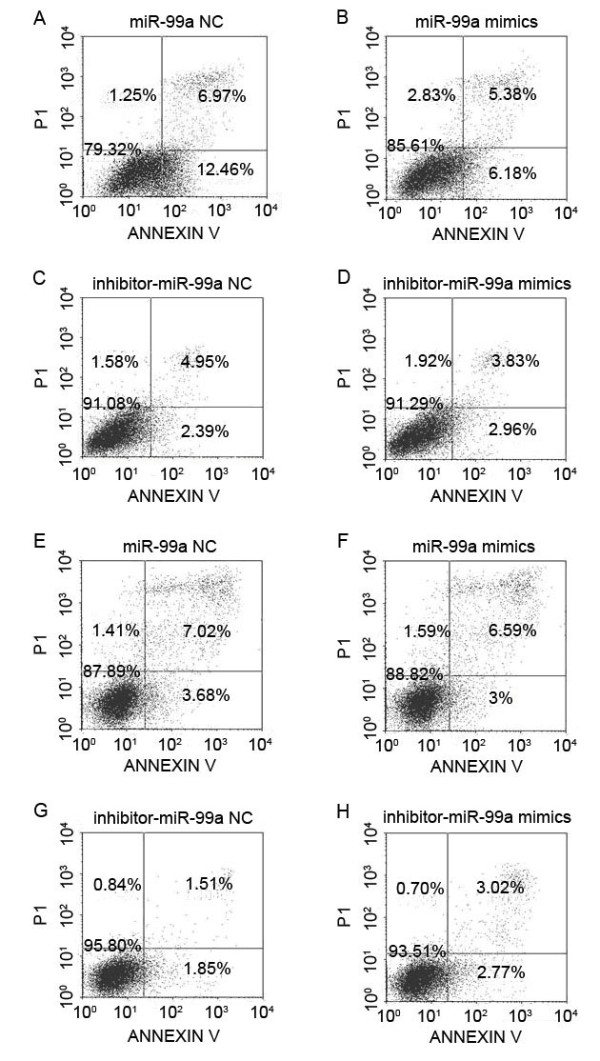
MiR-99a inhibits the apoptosise of HL60 and K562 cells. Apoptosis assessment by Annexin V/propidium iodide staining shows the apoptotic rates of K562 and HL60 cells transfected with miR-99a mimics, inhibitor-miR-99a or corresponding NC respectively. The fourth quadrant represents apoptotic cells detected by flow cytometry. (A, B) Of the K562 cells measured at 72 h after transfection, miR-99a inhibits apoptosis and the inhibition rate is 50.3%. (A) miR-99a NC, (B) miR-99a mimics. P < 0.05. (C, D) Of the K562 cells at 48 h, inhibitor-miR-99a prevents the inhibition of apoptosis and the prevention rate is 24%. (C) inhibitor-miR-99a NC, (D) inhibitor-miR-99a mimics. P > 0.05. (E, F) Of the HL60 cells at 96 h, miR-99a inhibits apoptosis and the inhibition rate is 18.5%. (E) miR-99a NC, (F) miR-99a mimics. P > 0.05. (G, H) Of the HL60 cells at 48 h, inhibitor-miR-99a prevents the inhibition of apoptosis and the prevention rate is 50%. (G) inhibitor-miR-99a NC, (H) inhibitor-miR-99a mimics. P < 0.05.